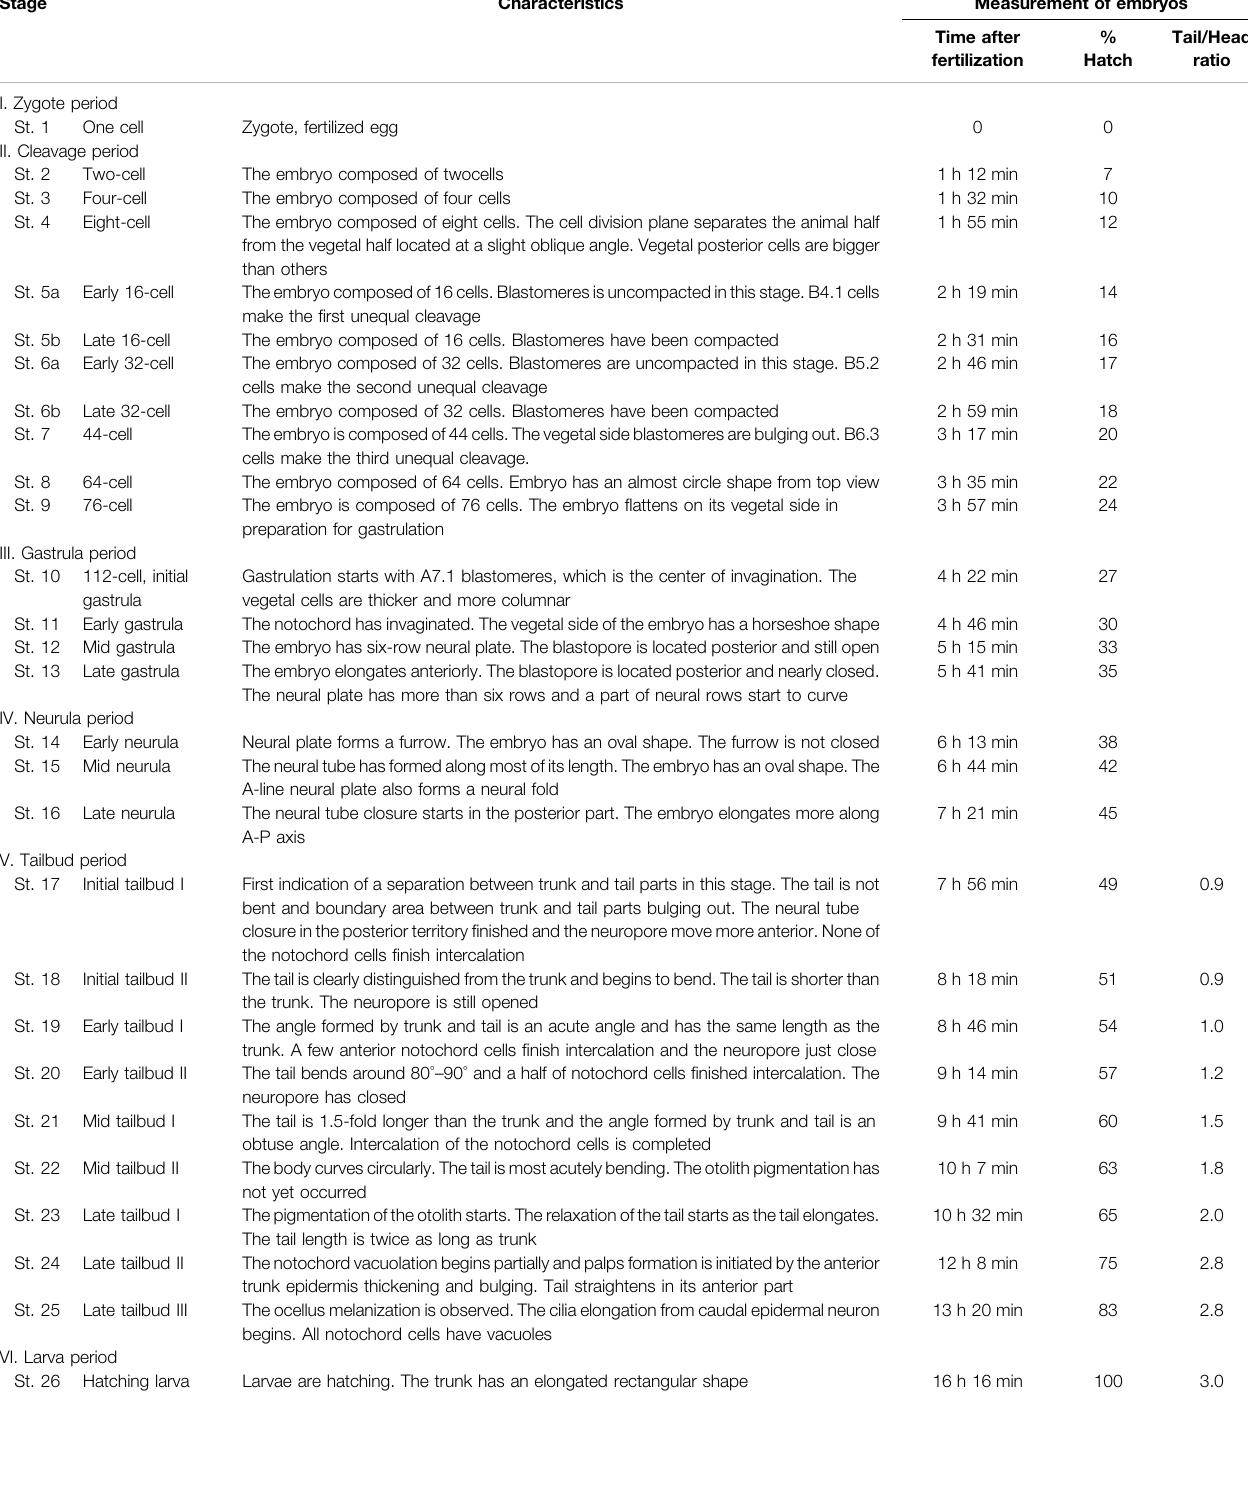
TABLE 1 | Stages of Early Embryonic Development in Ascidiella aspersa . From the left column. A total of 26 stages were divided into six periods: “ Characteristics ” is mainly basedontheobservation underdissecting microscopy. “ Measurementofembryos ” :Timeafterfertilization(averageat20 ° C,inStage1,4to24, N (cid:1) 11;Stage2and25, N (cid:1) 9; Stage 3, N (cid:1) 10; Stage 26, N (cid:1) 2), % hatch (cid:1) rate of T (min)/969 (min) and ratio of tail/trunk length. Stage Characteristics Measurement of embryos